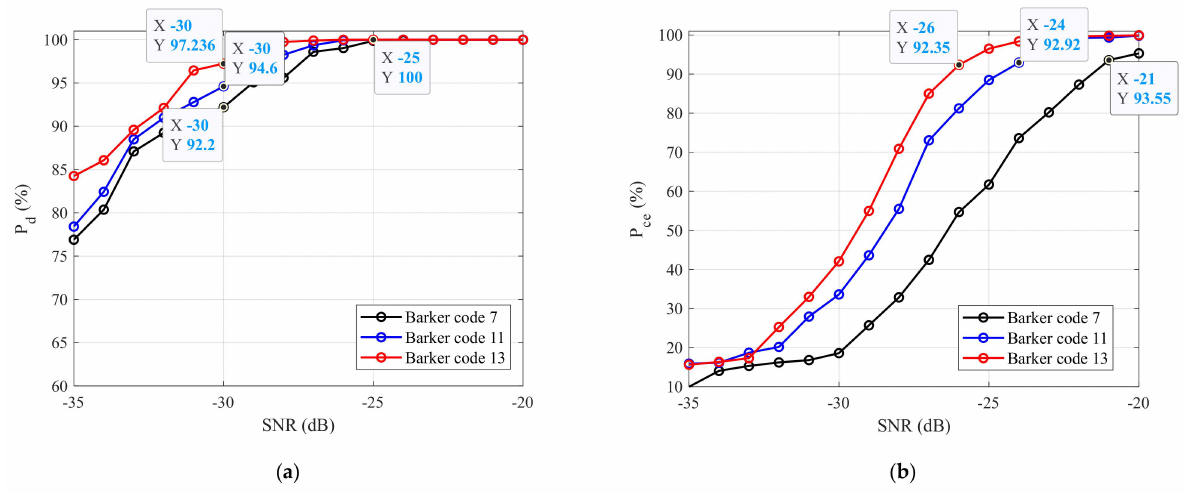
Figure 6. The simulation results: ( a ) probability of detection, and ( b ) probability of pulse width